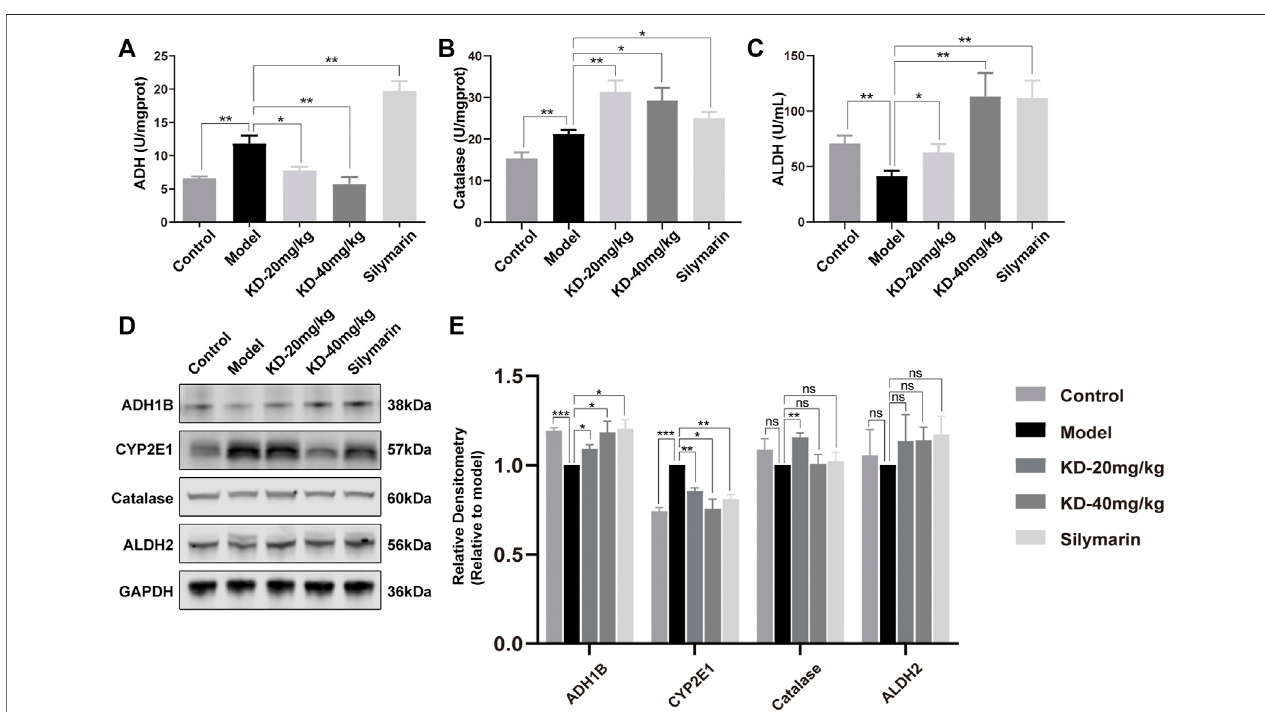
FIGURE 4 | Effects of KD on ethanol metabolism in mice. (A) ADH activity in mice liver homogenates. (B) Catalase activity in mice liver homogenates. (C) ALDH activityinmiceliverhomogenates.( n (cid:1) 5 – 7). (D) ExpressionoftheADH1B,catalase,CYP2E1,andALDH2proteinsinmicelivertissue. (E) Quantitativeanalysisofprotein expression ( n (cid:1) 3). GAPDH was used as a loading control and for data normalization. Data represent the mean ± SEM. ns, not signi fi cant. * p < 0.05, ** p < 0.01, *** p < 0.001 vs. the model